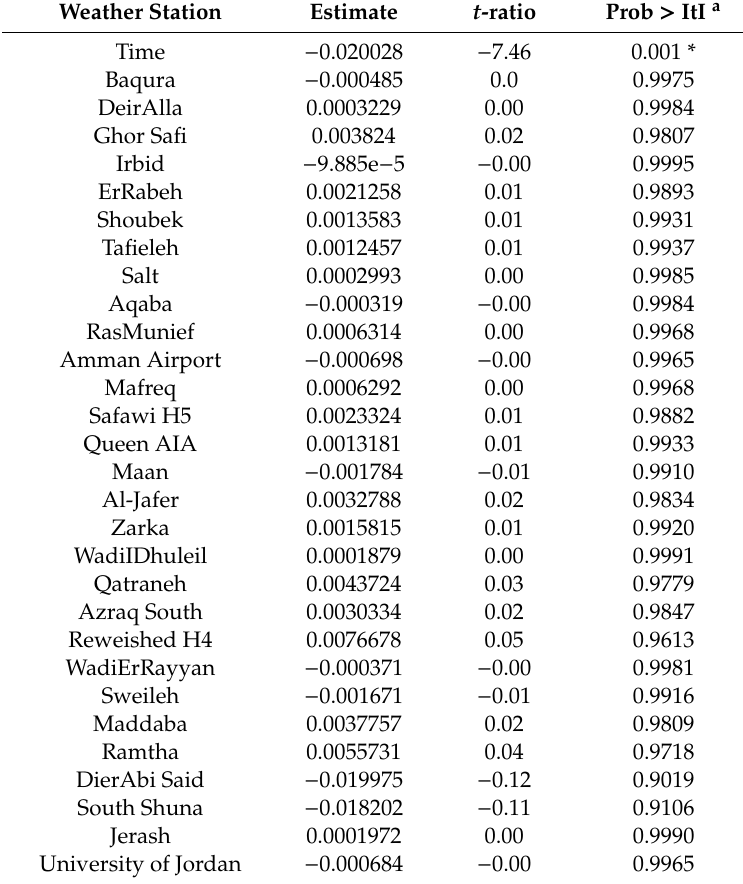
Table 6. Regression analysis for SPI 12 regarding spatial and temporal